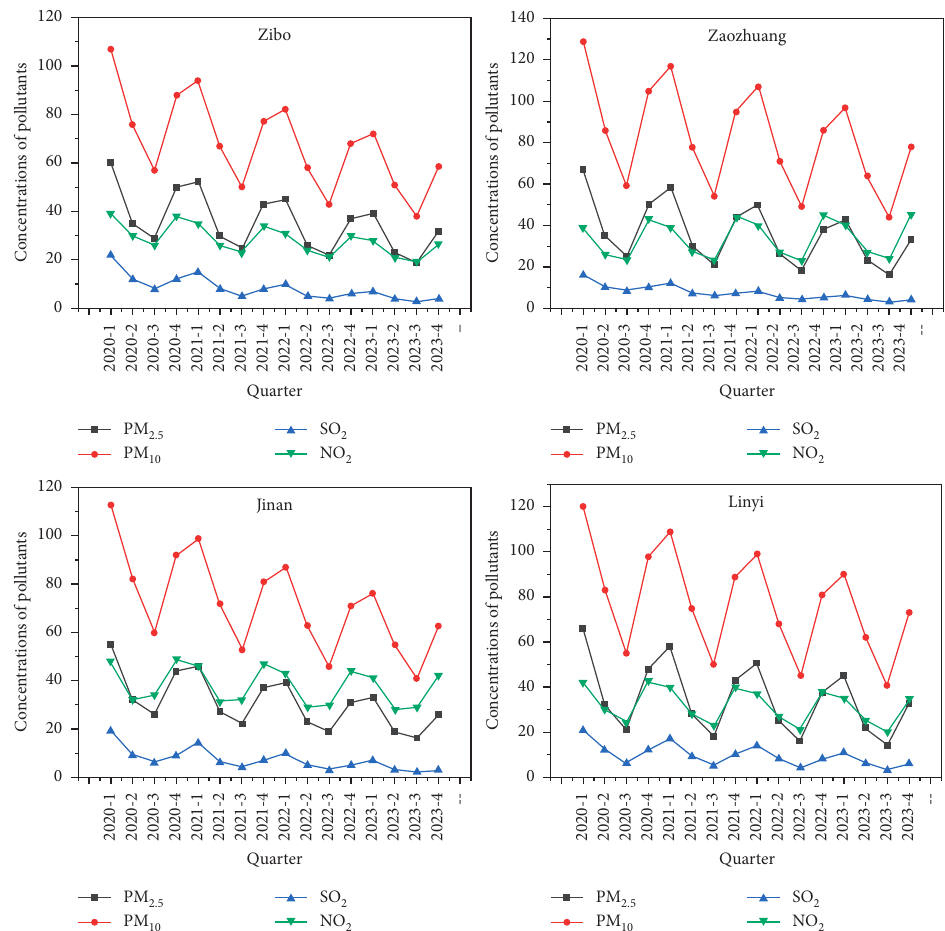
Figure 5: The predicted concentrations of four pollutants in four cities in Shandong Province.